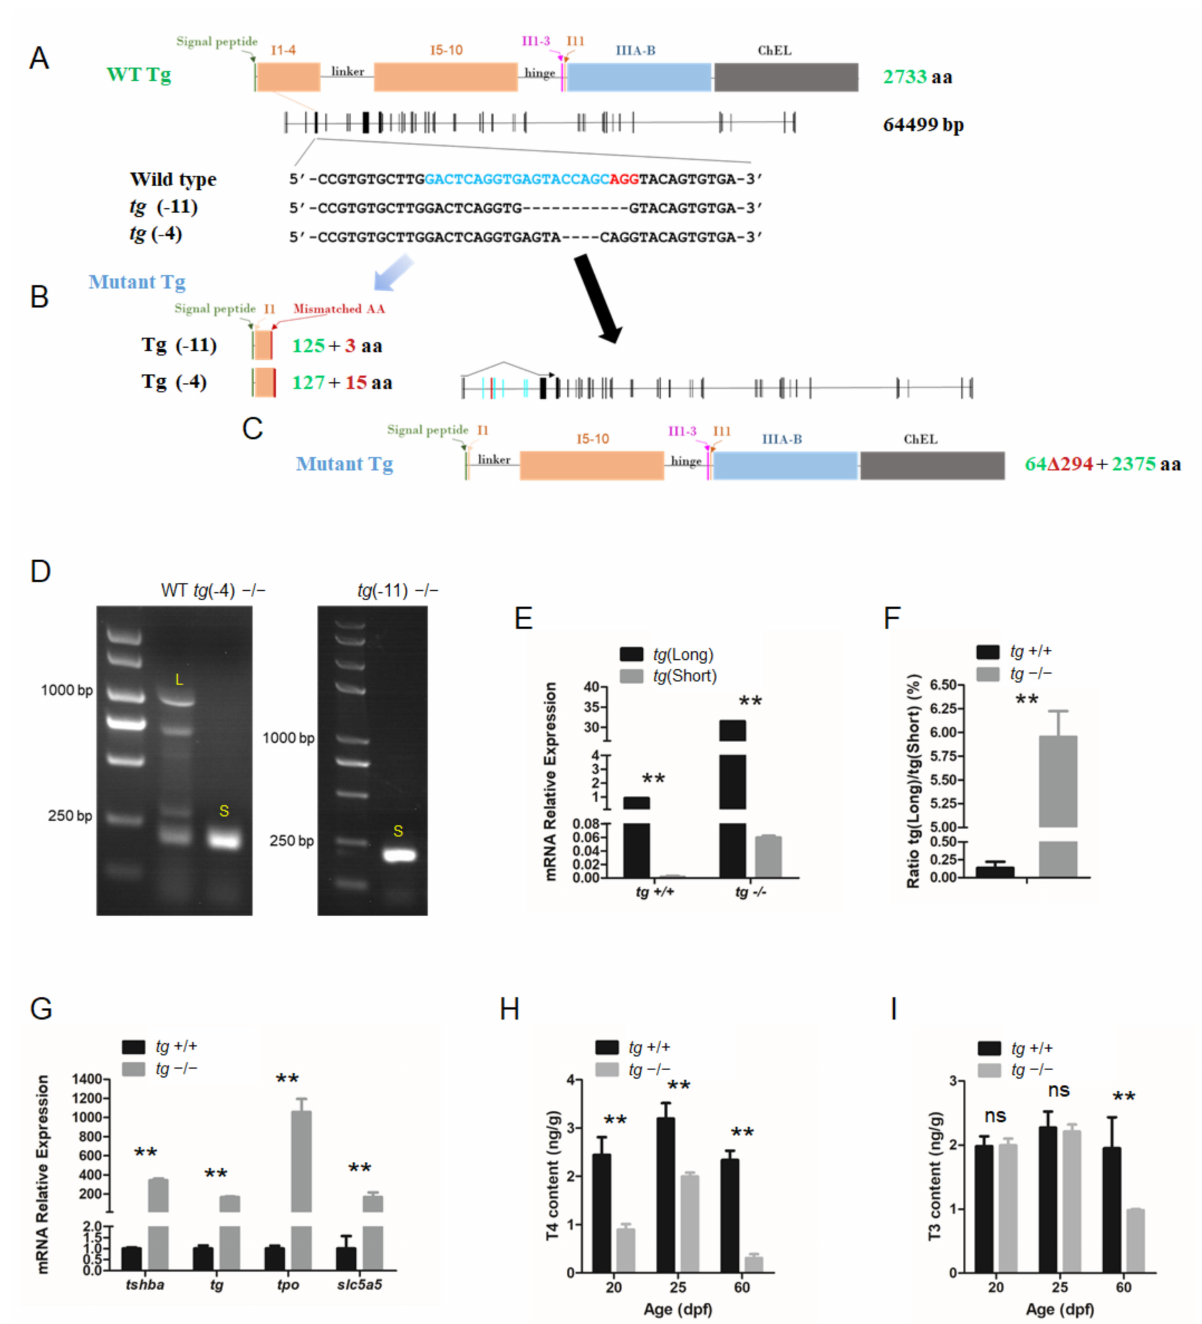
Figure 6. Generation of tg mutant zebrafish. ( A ) Schematic illustration representing the zebrafish Tg protein, the genomic structure of tg , and the CRISPR target site on exon 4. Sequencing of the tg CRISPR target site in wild type, tg (-4) mutant, and tg (-11) mutant zebrafish lines are shown in the lower panel. ( B ) The predicted truncated Tg proteins resulting from premature translational terminations are shown. ( C ) Proteins resulting from the alternative short transcript are shown. ( D ) The alternative short transcripts can be amplified in wild-type fish and tg mutants. The long transcripts were indicated by the letter L. The short transcripts were indicated by the letter S. ( E ) Quantification of the expression levels of the tg full-length transcript and short transcript in tg mutants and their wild-type siblings. ( F ) Ratio of the tg full-length transcript and short transcript expression in tg mutants and their wild-type siblings. ( G ) Quantitative RT-PCR analyses of tshba , tg , tpo , and slc5a5 expression levels in tg mutants and their wild-type siblings at 5 dpf. ( H ) Whole-body T4 contents of tg mutants and their wild-type siblings at the 20, 25, and 60 dpf stages. ( I ) Whole-body T3 contents of tg mutants and their wild-type siblings at the 20, 25, and 60 dpf stages.** p < 0.01, ns: No